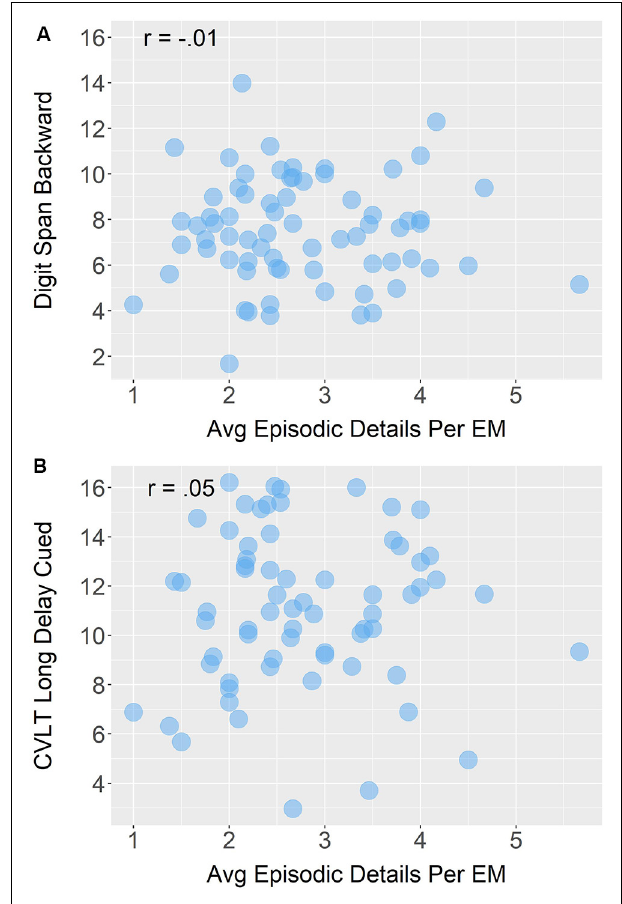
FIGURE 7 | Bivariate Spearman correlations between average (avg) episodic detail generation in sound files that contained episodic memories (EM) and (A) measures of working memory (i.e., Digit Span Backward raw score) and (B) episodic memory (i.e., California Verbal Learning Test [CVLT] long delay cued recall raw score). The jitter of data points was used to ensure minimal overlap, which pushed some CVLT scores of 16 (maximum score) above that